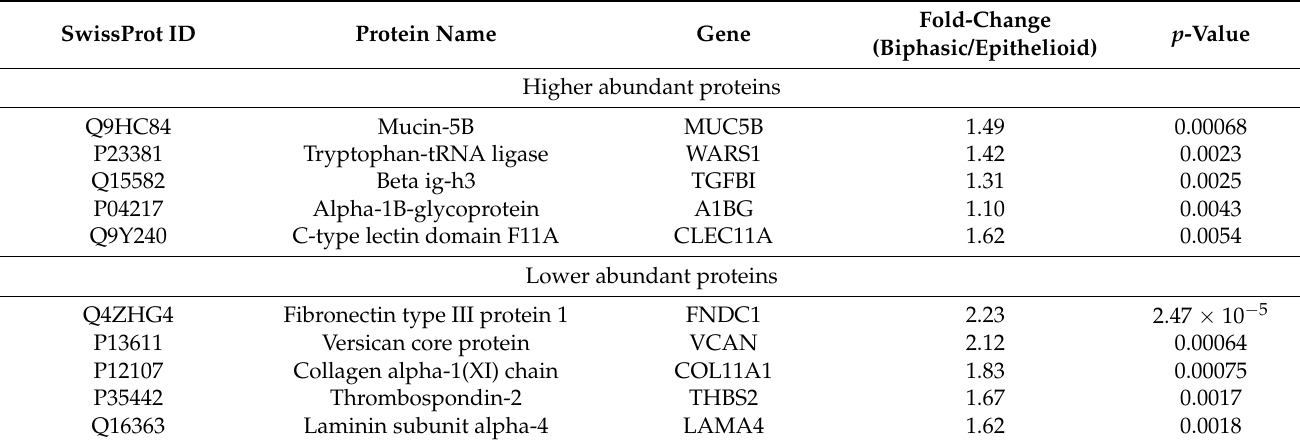
Figure 2. ROC analysis of Random Forest classifiers trained on either ( a ) mesothelin or ( b ) fibulin-3, measured with either discovery-based MS (red) or a confirmative targeted MS assay (blue). Table 4. Five most significantly regulated proteins between biphasic and epithelioid MPM subtypes in the two